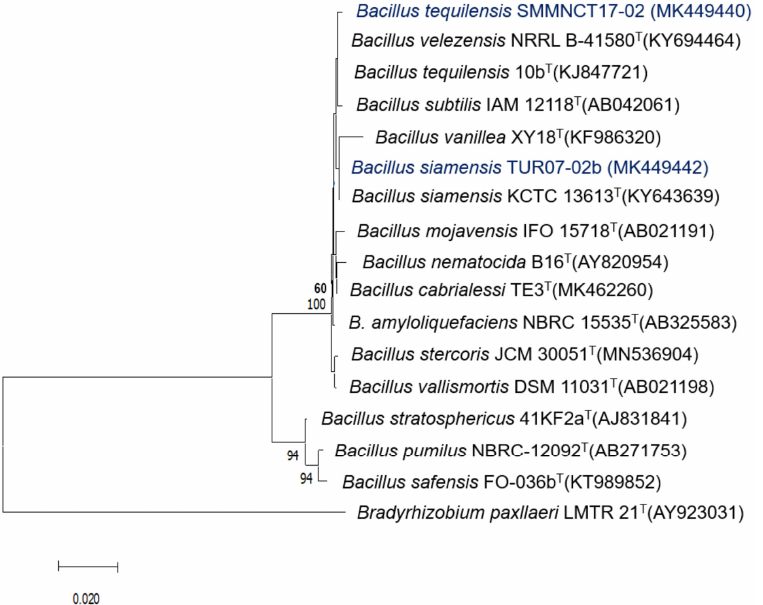
Figure 2. Neighbor-joining phylogenetic tree based on 16S rDNA gene sequences (1292 positions) showing the relationships among endophytes Bacillus species isolated from rice in Northern Peru and closely related species of the genus Bacillus . A bootstrap value indicates the significance of each branch (as a percentage) calculated for 1000 subsets (only values greater than 50% are indicated). Bar, two substitutions per 100 nucleotide positions. The 16S rDNA sequence of Bradyrhizobium paxllaeri LMTR-21 T was used as an outgroup.